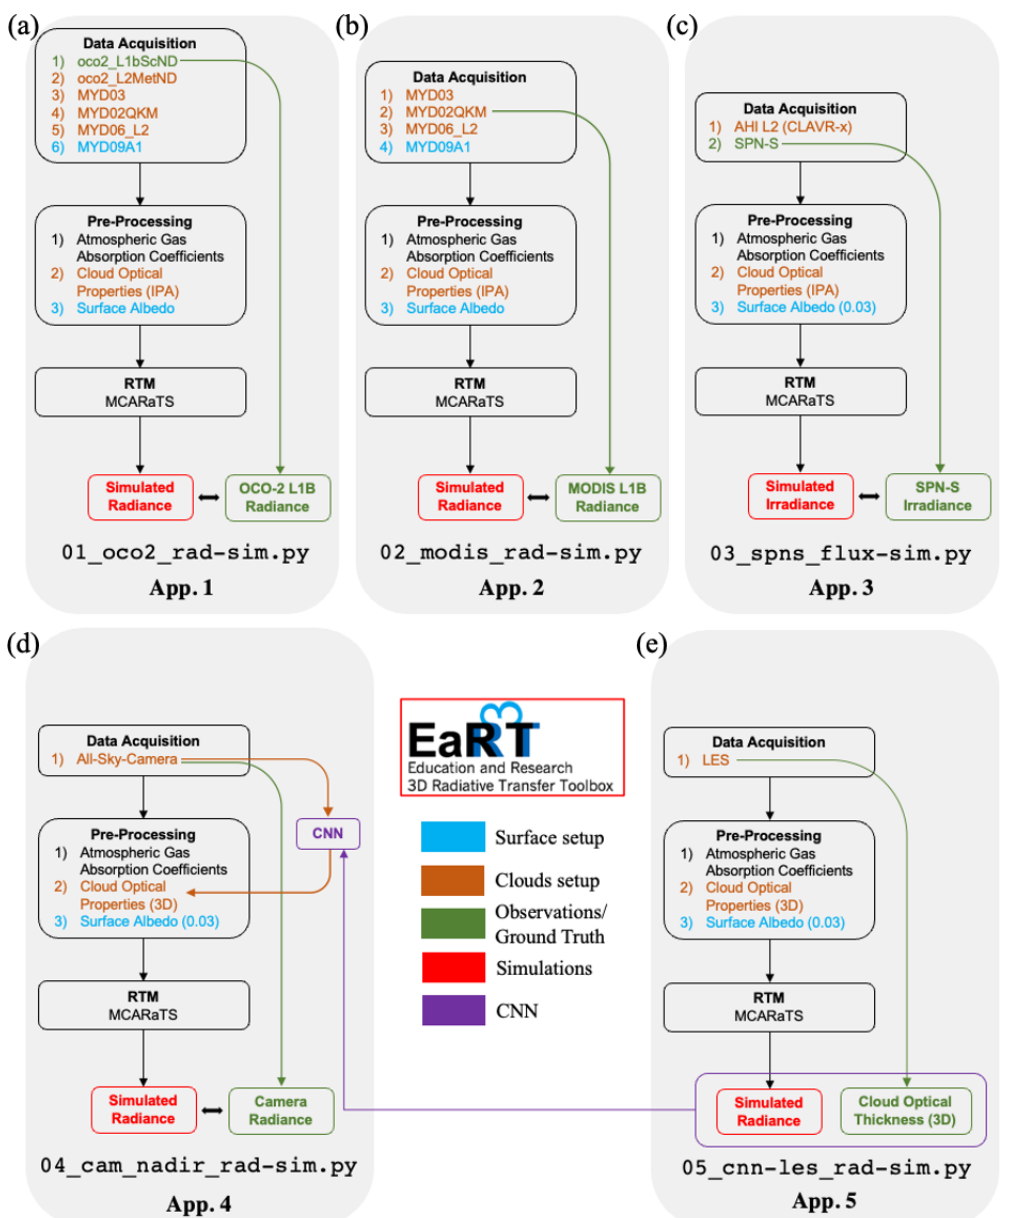
Figure 1. Flow charts of EaR 3 T applications for (a) OCO-2 radiance simulation at 768.52nm (data described in Sect. 2.2.1 and 2.2.2, results discussed in Sect. 4.1), (b) MODIS radiance simulation at 650nm (data described in Sect. 2.2.1, results discussed in Sect. 4.2), (c) SPN-S irradiance simulation at 745nm (data described in Sect. 2.2.3 and 2.2.4, results discussed in Sect. 5), (d) all-sky camera radiance simulation at 600nm (data described in Sect. 2.2.5, results discussed in Sect. 6), and (e) radiance simulation at 600nm based on LES data for CNN training (Appendix B). The data products and their abbreviations are described in Sect.